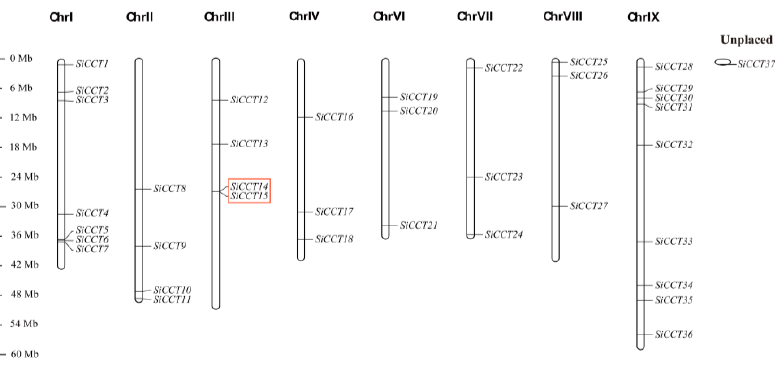
Figure 1. Chromosomal location of putative SiCCT genes. Thirty-six genes were mapped to the millet chromosomes, and one predicted gene was not mapped. The chromosome number is shown above each chromosome, and the length of each chromosome is indicated on the left in megabases (MB).